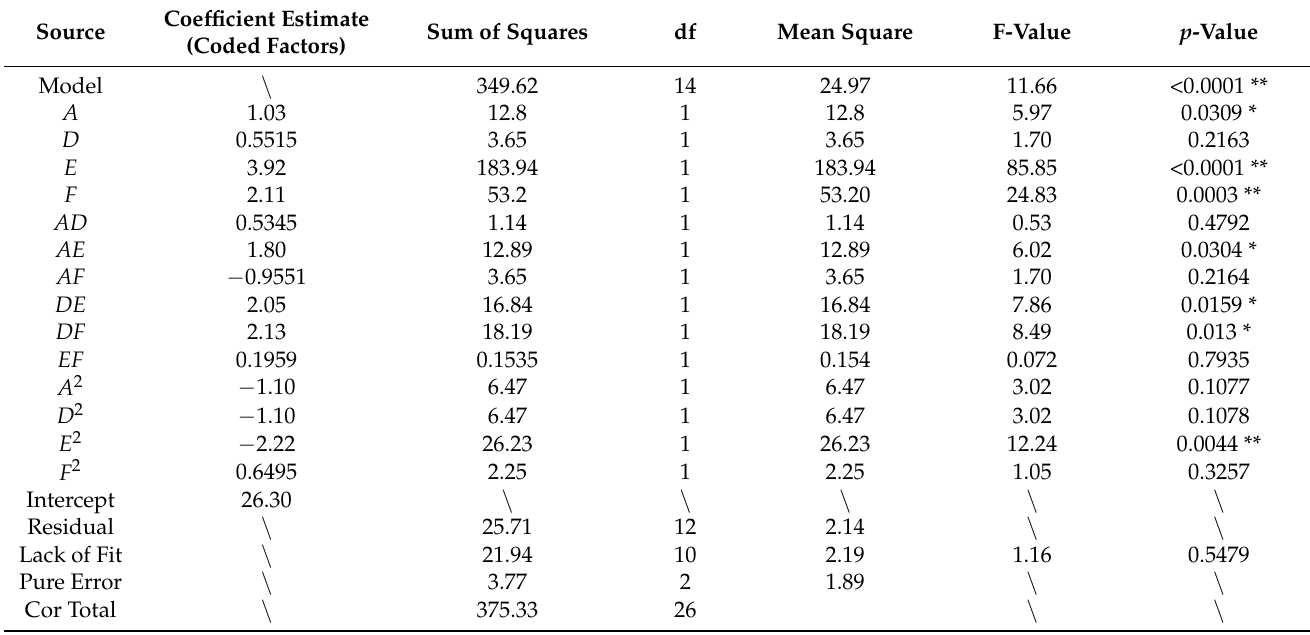
Table 6. ANOVA for contact-parameter-response surface test’s